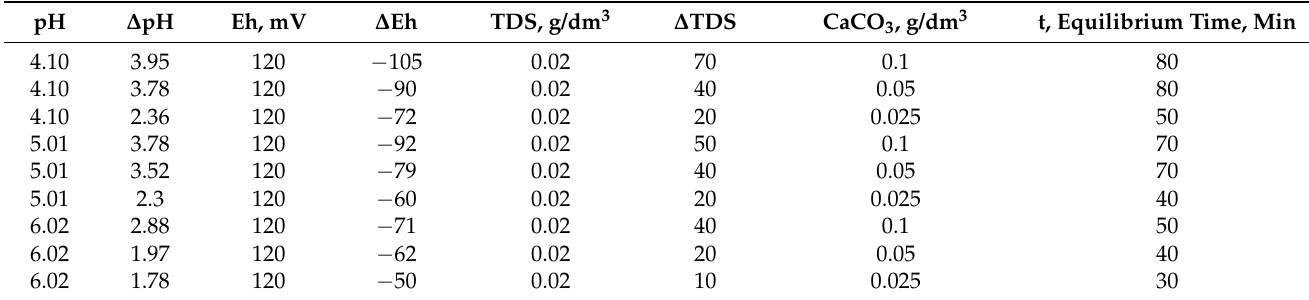
Table 1. Results of experimental studies of water pH increase using dispersed, thermally activated